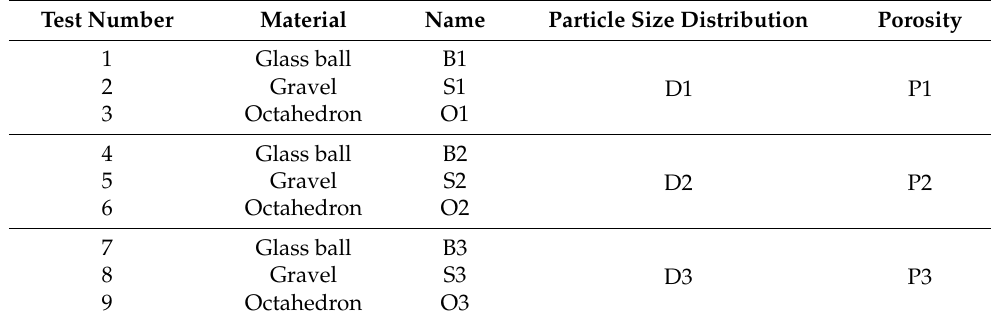
Figure 2. Experimental process. Table 1. Test sample information.